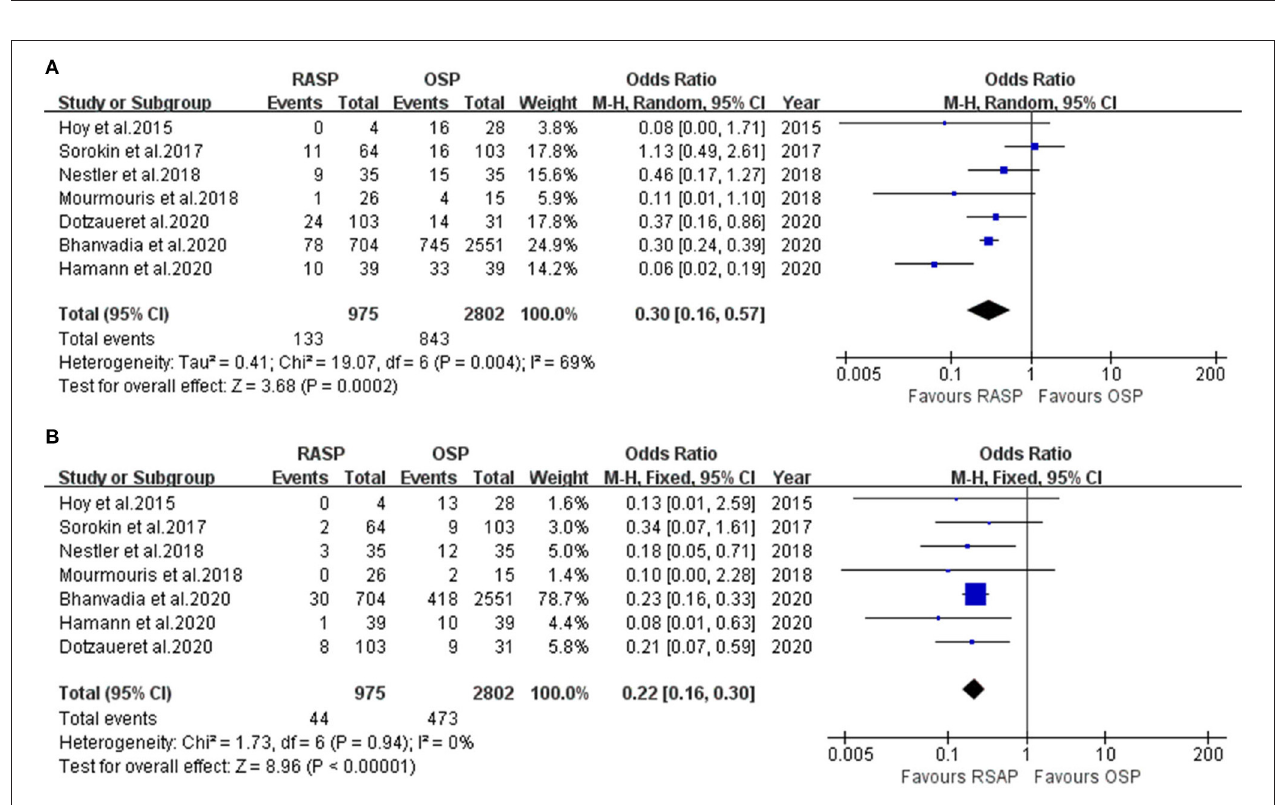
FIGURE 4 | Forest plot and meta-analysis of TR (A) and complications (B) .